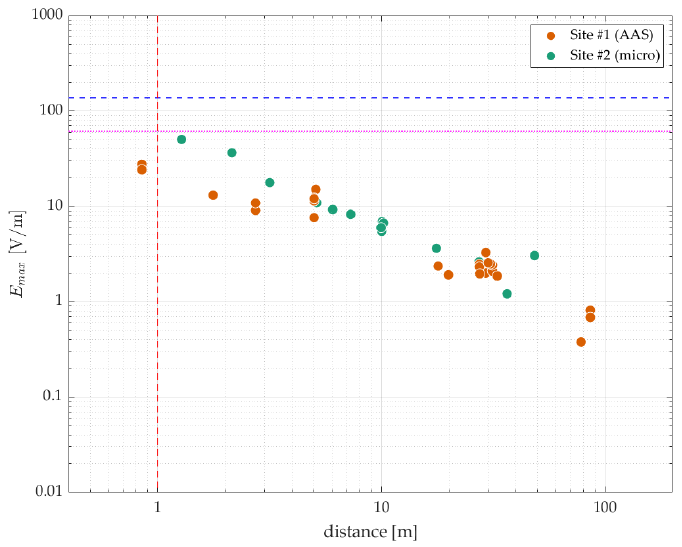
Figure 4. Theoretical maximum exposure levels E max (in V/m) obtained at two sites with a 5G new radio (NR) base station — scaled to small-cell powers [2,3] — as a function of the distance to the antenna. Only positions within the scanning range of the base station radio are featured here. Maximum permissible exposure (MPE) limits issued by ICNIRP [17] are indicated by the blue dashed line (occupational) and the magenta dotted line (general public). The red dashed line indicates the boundary between occupational (<1 m) and general public exposure (>1 m) (see D m for E100 in Table 1).